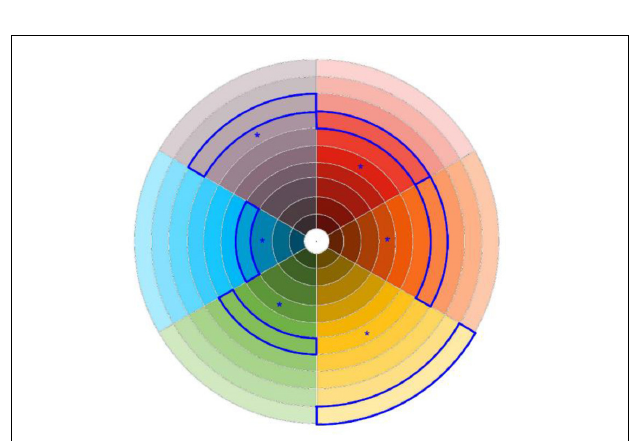
FIGURE 9 | Color lightness preference (blue frame) as a function of the six-building interior color. The asterisks show the actual color lightness level in the six